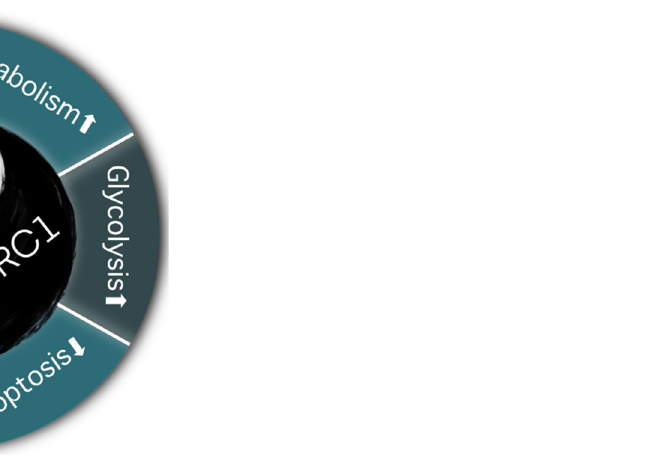
Figure 3. AMPK and mTORC1 are components of conserved pathways that evolved via a yin-yang-like antagonistic mechanism controlling catabolism and anabolism [94]. The AMPK pathway prompts cell autophagy and regulates catabolic metabolism and oxidative phosphorylation (OXPHOS) under restricted nutrient and energy conditions. The mTOCR1 pathway preferentially activates anabolic metabolism and glycolysis, while suppressing cell apoptosis [58].